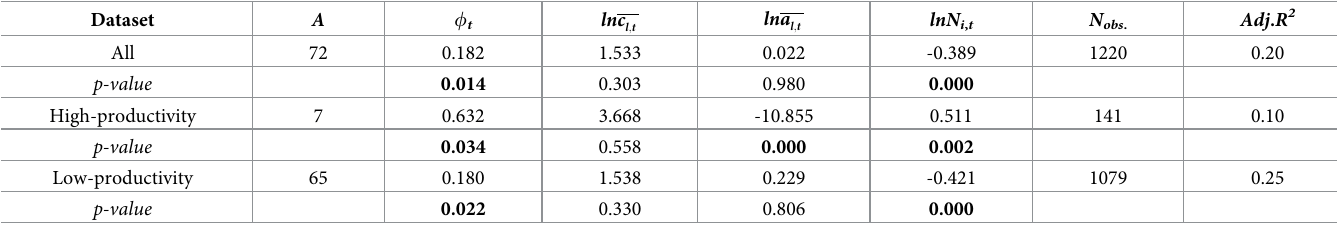
Table 7. Parameter estimates for the citation model of super ties for c